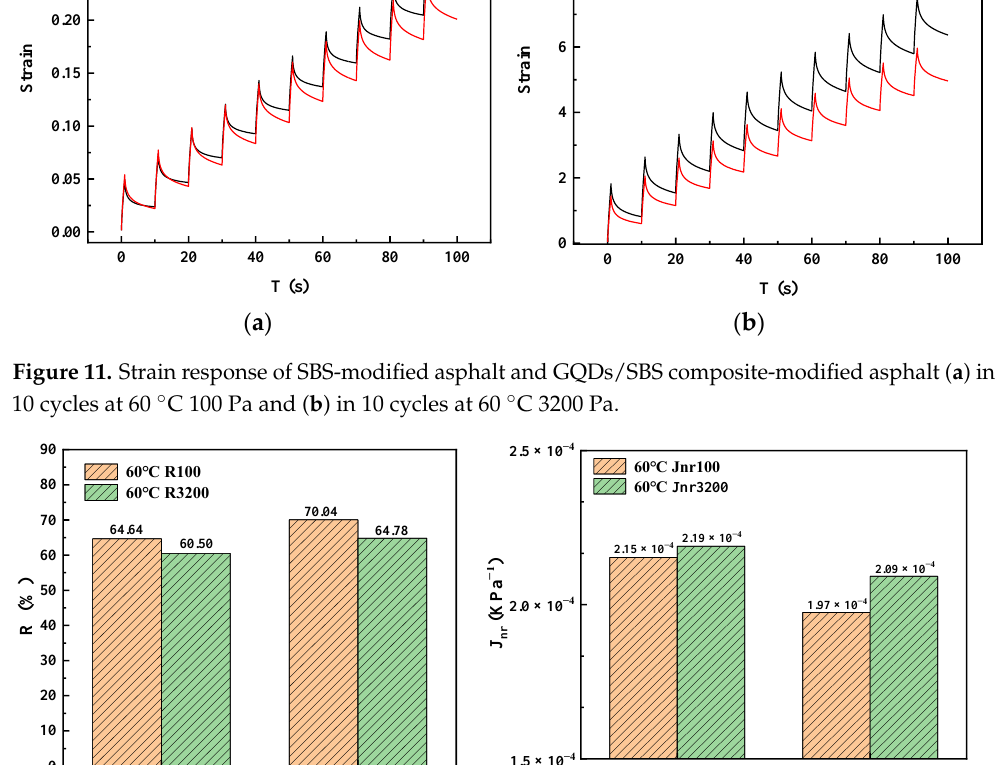
Figure 11. Strain response of SBS-modified asphalt and GQDs/SBS composite-modified asphalt ( a ) in 10 cycles at 60 °C 100 Pa and ( b ) in 10 cycles at 60 °C 3200 Pa.